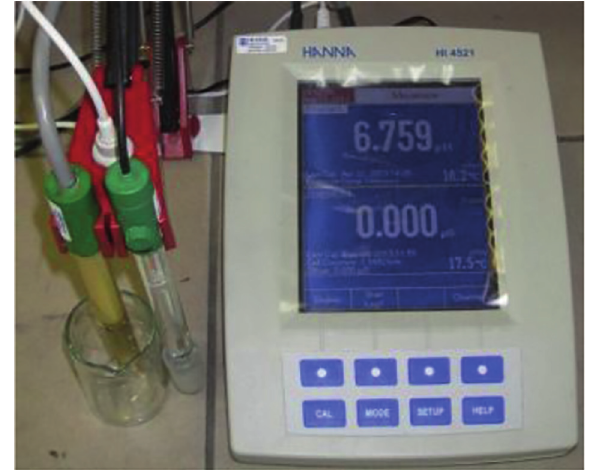
Fig. 1. Equipment for measuring electrical capacitance Fig. 2. Equipment for measuring the electrical conductivity of char